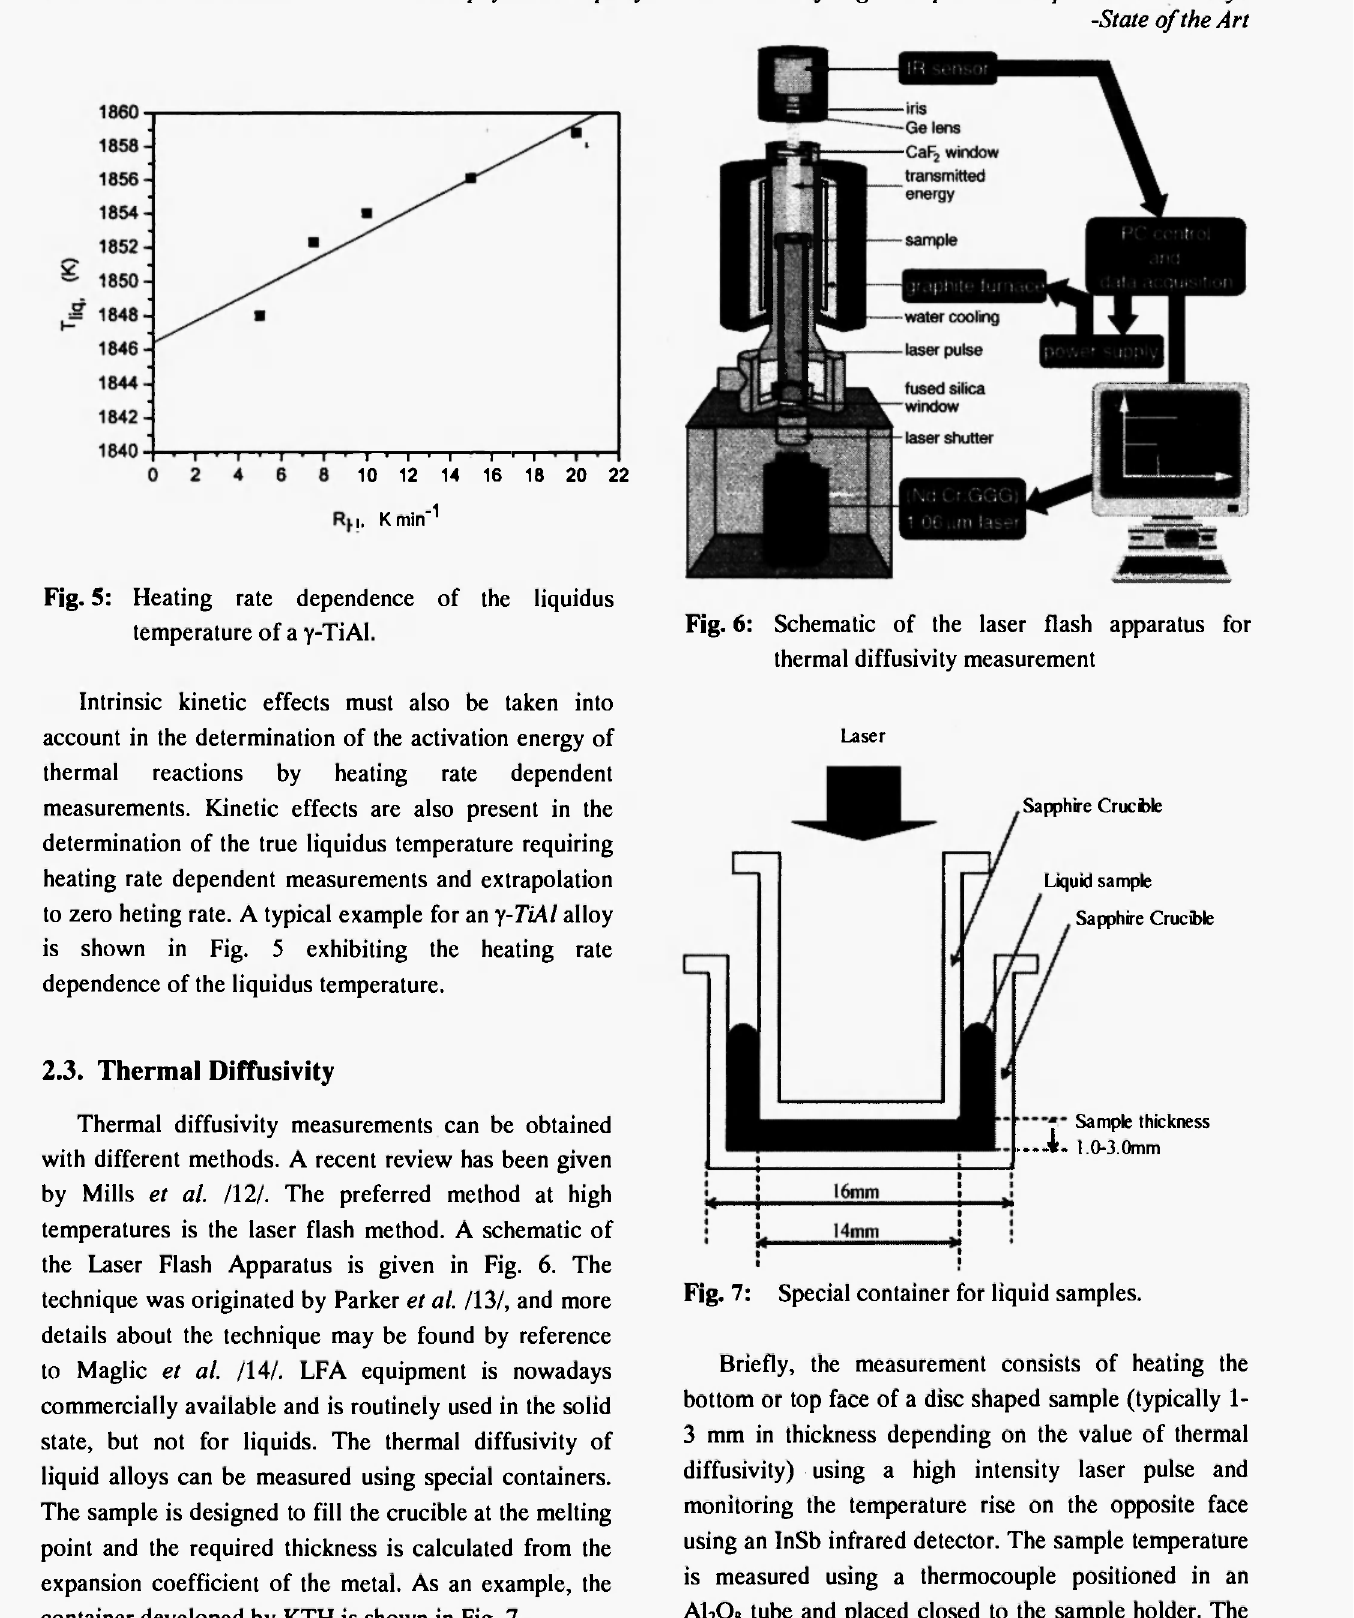
Fig. 7: Special container for liquid samples. Briefly, the measurement consists of heating the bottom or top face of a disc shaped sample (typically 1- 3 mm in thickness depending on the value of thermal diffusivity) using a high intensity laser pulse and monitoring the temperature rise on the opposite face using an InSb infrared detector. The sample temperature is measured using a thermocouple positioned in an A1 2 O s tube and placed closed to the sample holder.